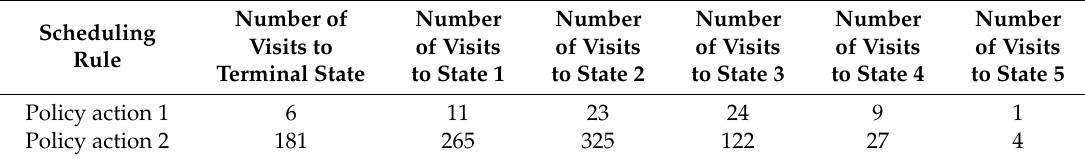
Table 8. Order picking workload distribution (number of orders per pick zone) among pick zones under emergence, for the different policy actions, for one batch of 28 orders with mean order size three line items per order and four emergency orders. Workload distribution under normal conditions (i.e., in the absence of emergency orders) has been included.